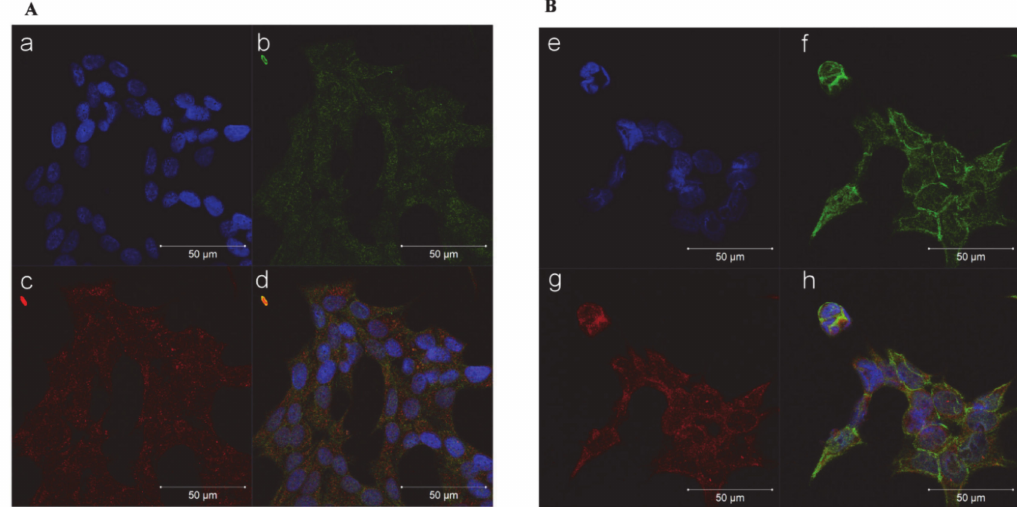
Figure 5. Trabectedin exposure a ff ects the subcellular localization of β -catenin in NCIH295R cells. Cells were treated with 0.15 nM trabectedin for 3 days. Untreated ( A ) and trabectedin ( B ) treated cells were analyzed for β -catenin localization following by incubation with Hoechst for nuclear staining. Panels a, e: Hoechst; panels b, f: β -catenin; panels c, g: constitutive proteasome subunit PSMB5; panels d, h: merge. The scale bar of 50 µ m is automatically inserted by the software ZEN